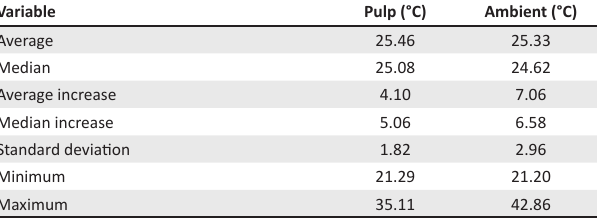
TABLE 1: Temperature dispersion of navels load two: Degreening temperature surge. Variable